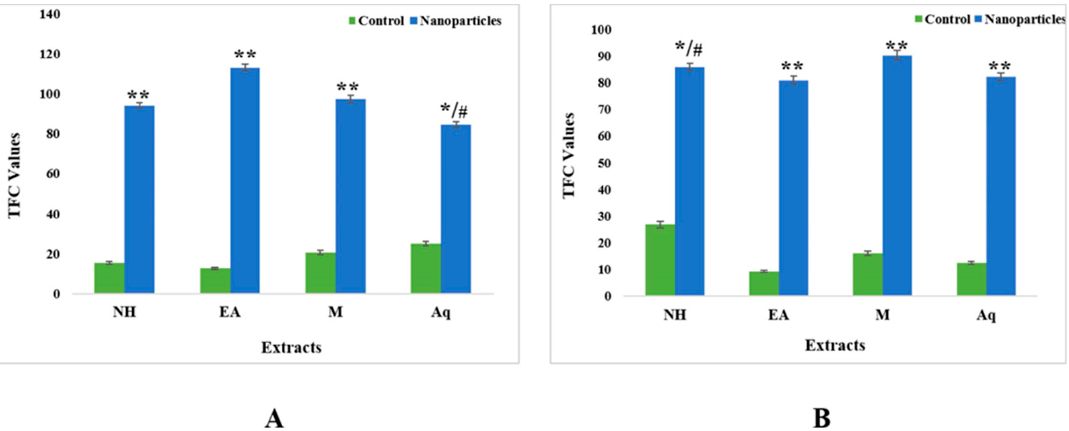
Figure 8. Total flavonoid contents of control and nanoparticles from ( A ) leaf and ( B ) fruit extracts of C. colocynthis . Mean ± SD is expressed as */# p < 0.05, ** p < 0.01.